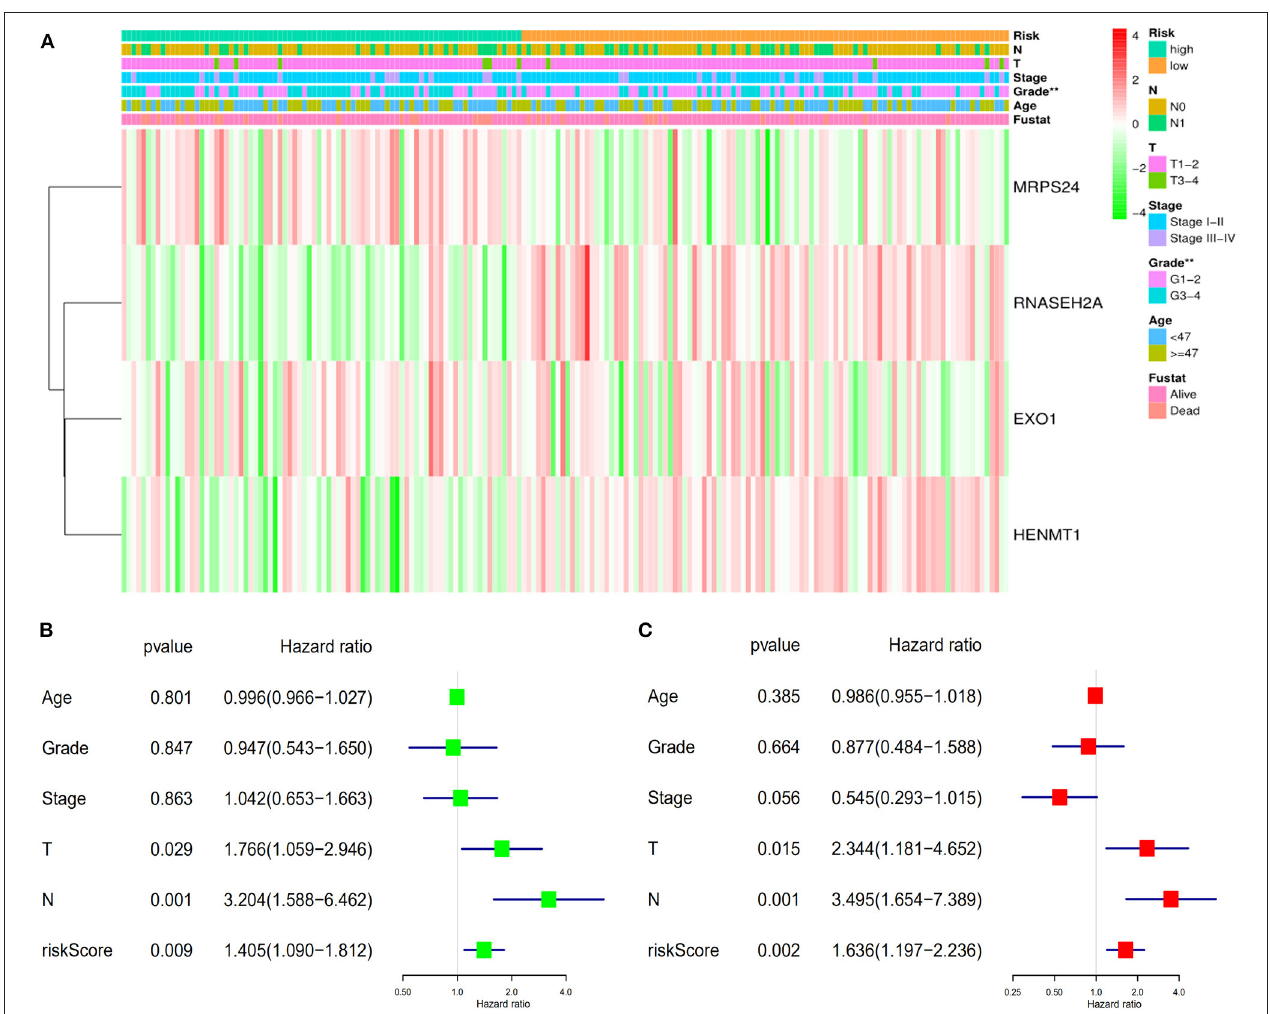
FIGURE 8 | Verifies the accuracy of the prognostic scoring model. (A) Differences in the distribution of clinical factors between high and low risk groups. (B) Univariate prognostic analysis. (C) Multivariate independent prognostic analysis. ** P <